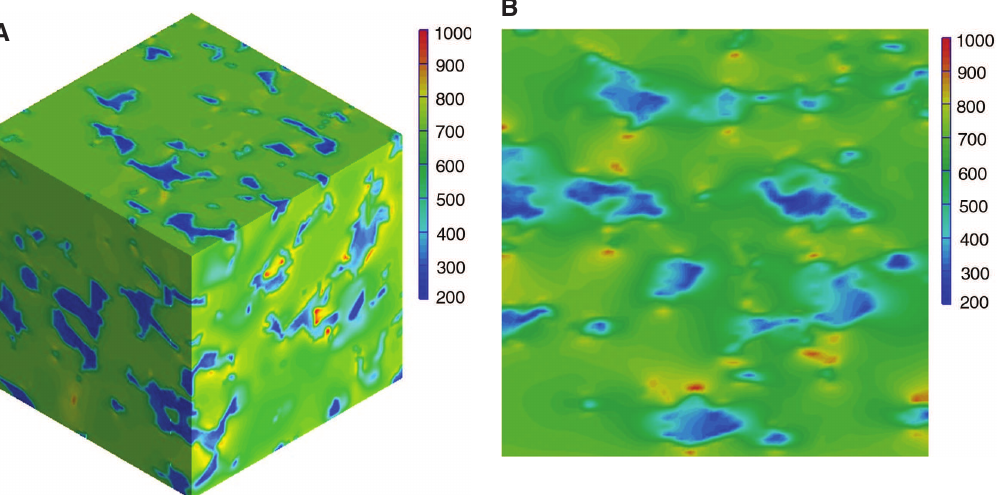
Figure 19: Stress field obtained on the basis of 3D microgeometry containing cobalt islands: (A) isometric view on the RVE and (B) exemplary section view